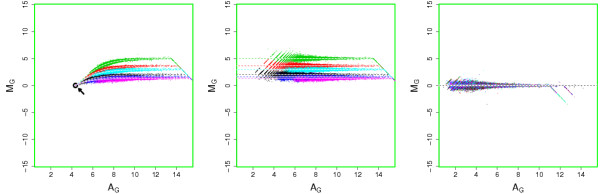
Log-ratio and log-intensity plots of raw, translated, and calibrate signals. The affine transformation gives curvature in the M versus A plots, which is corrected for by the affine normalization method. The three scatter plots show the within-channel log-ratio versus the log-intensity for each of the six PMT pairs based on the same data as in Figure 1. Left: Observed signal for different PMT pairs. For each pair the estimated  has been marked with a circle, cf. Figure 1. Mid: Bias corrected signals. Right: Bias and scale calibrated signals. The range of the M axis is twice the range of the A axis so that (6)-(7) appear as a rotation in the plots.